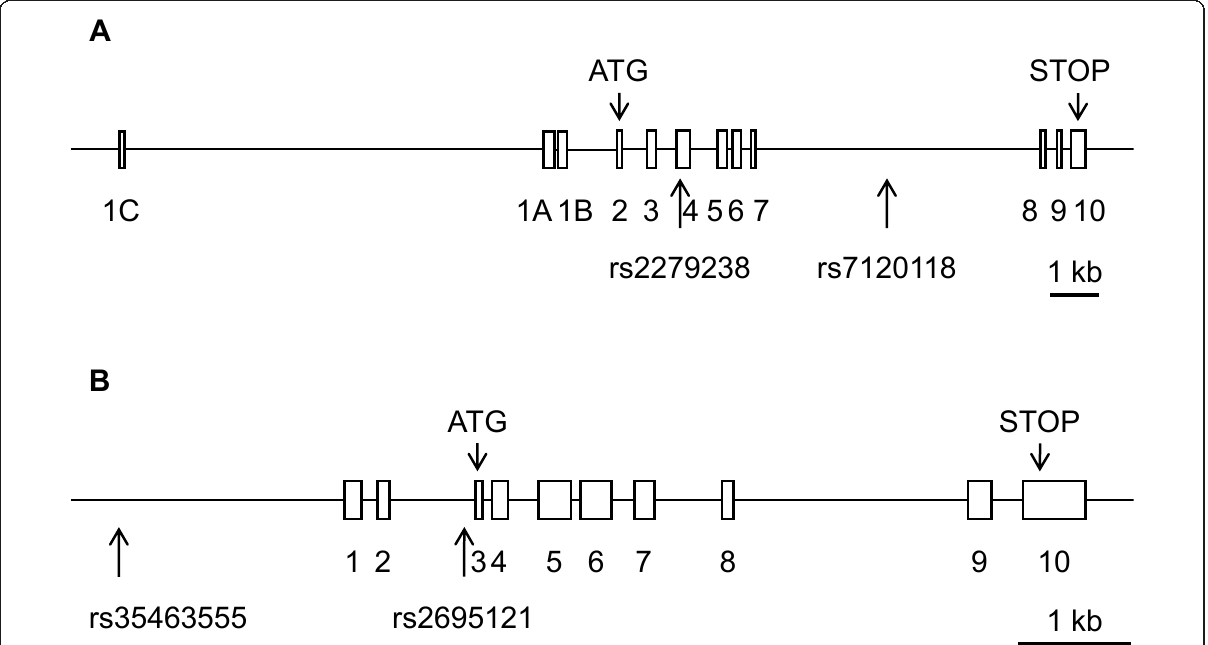
Figure 1 Schematic representation of the NR1H3 (LXRalpha) and NR1H2 (LXRbeta) genes showing the position of the genotyped SNPs . Rectangles indicate exons; lines indicate introns. Arrows under the schematic representation of the gene indicate the position of each genotyped SNP. Thick lines below the gene represent the 1 kb scale. A: schematic representation of the NR1H3 (LXRalpha) gene; B: schematic representation of the NR1H2 (LXRbeta)